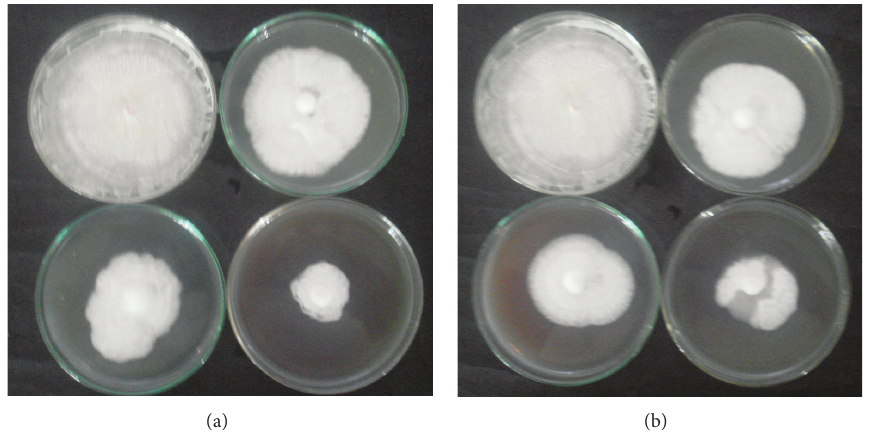
F 7: (a) Antifungal activity of p-NH